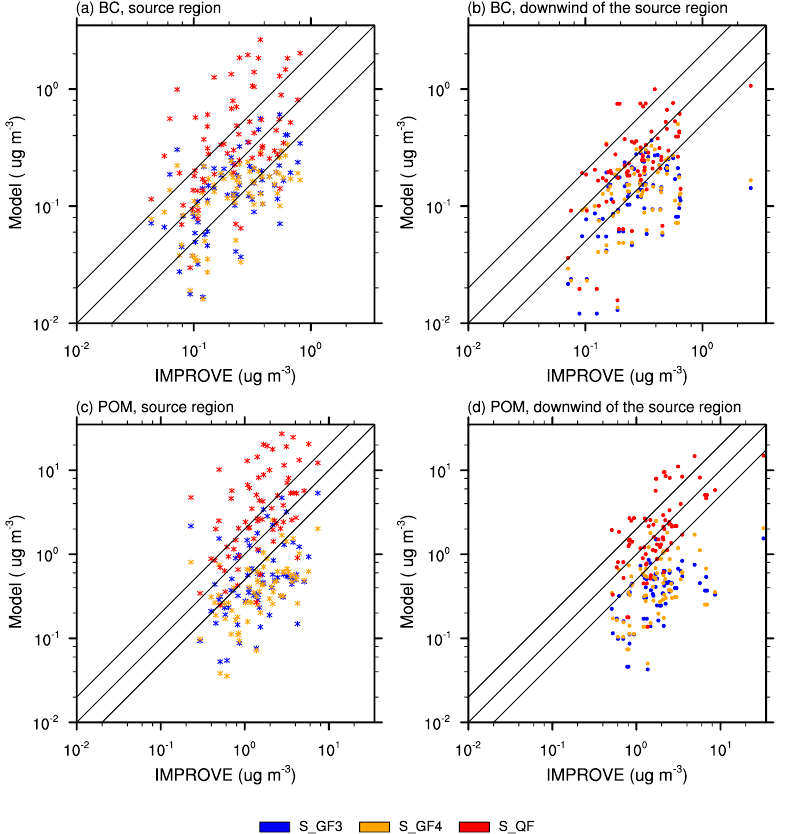
Figure 5. Evaluation of simulated BC (a, b) and POM (c, d) concentrations in group A simulations against the IMPROVE data at sites near the source and downwind of the source region. Locations of these sites are marked with the same symbol in Fig. 2.